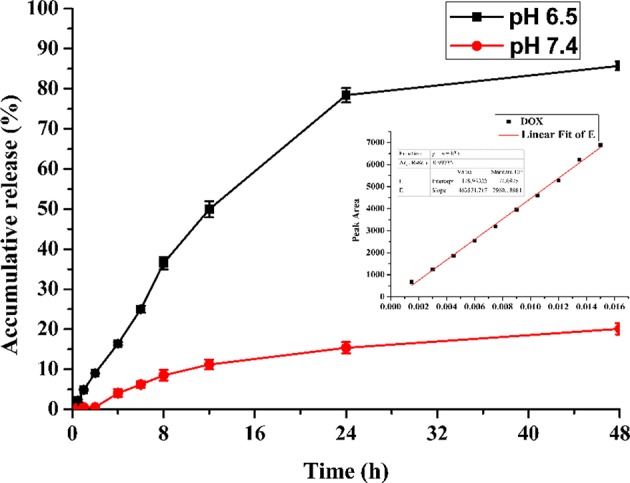
Accumulated DOX-release profiles of FA-CA-DOX micelles in 0.15 mol/L PBS (pH 6.5, pH 7.4) containing 3% SDS. Inset: linear curve of DOX.